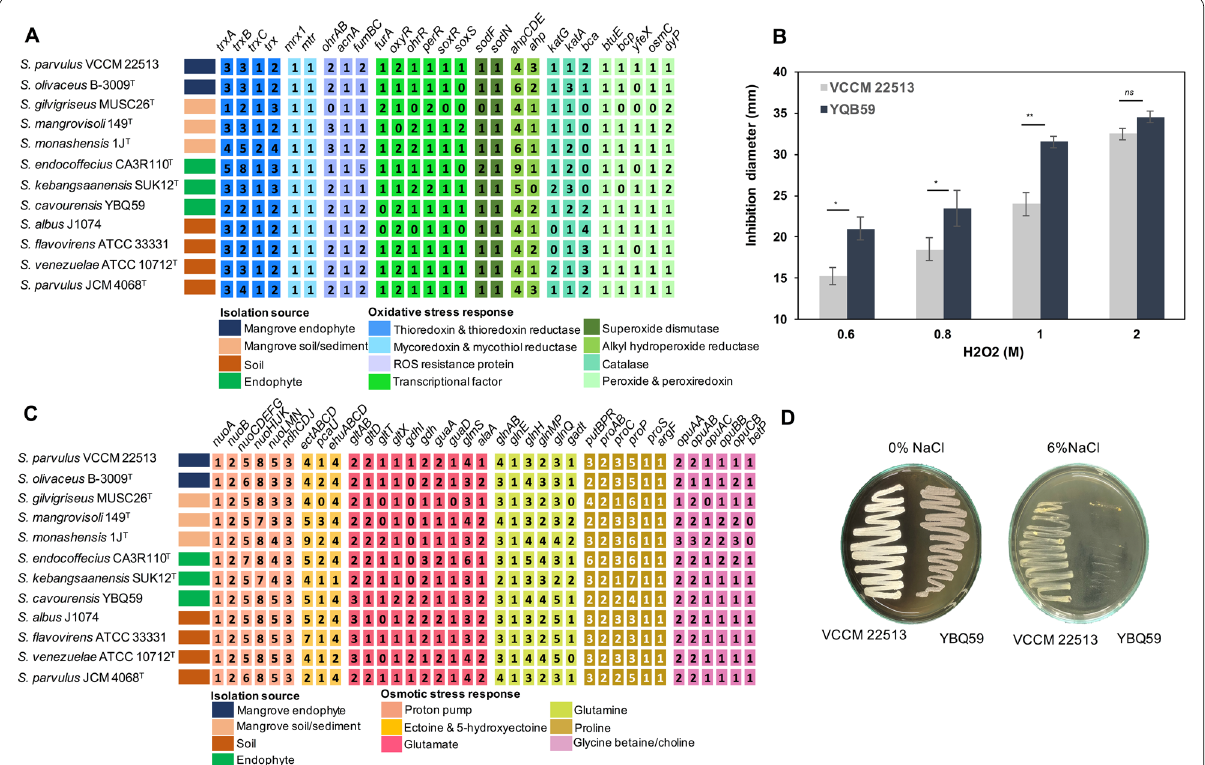
Fig. 4 Functional analysis of oxidative and osmotic stress tolerance of S. parvulus VCCM 22513 at genomic and phenotypic levels. Comparative analysis of genes involved in oxidative stress resistance ( A ) and osmotic stress ( C ) present in S. parvulus VCCM 22513 and 11 Streptomyces genomes. Functional response of S. parvulus VCCM 22513 and S. cavourensis YBQ59 to increasing concentrations of hydrogen peroxide (H 2 O 2 ) ( B ) and 0–6% (w/v) NaCl ( D